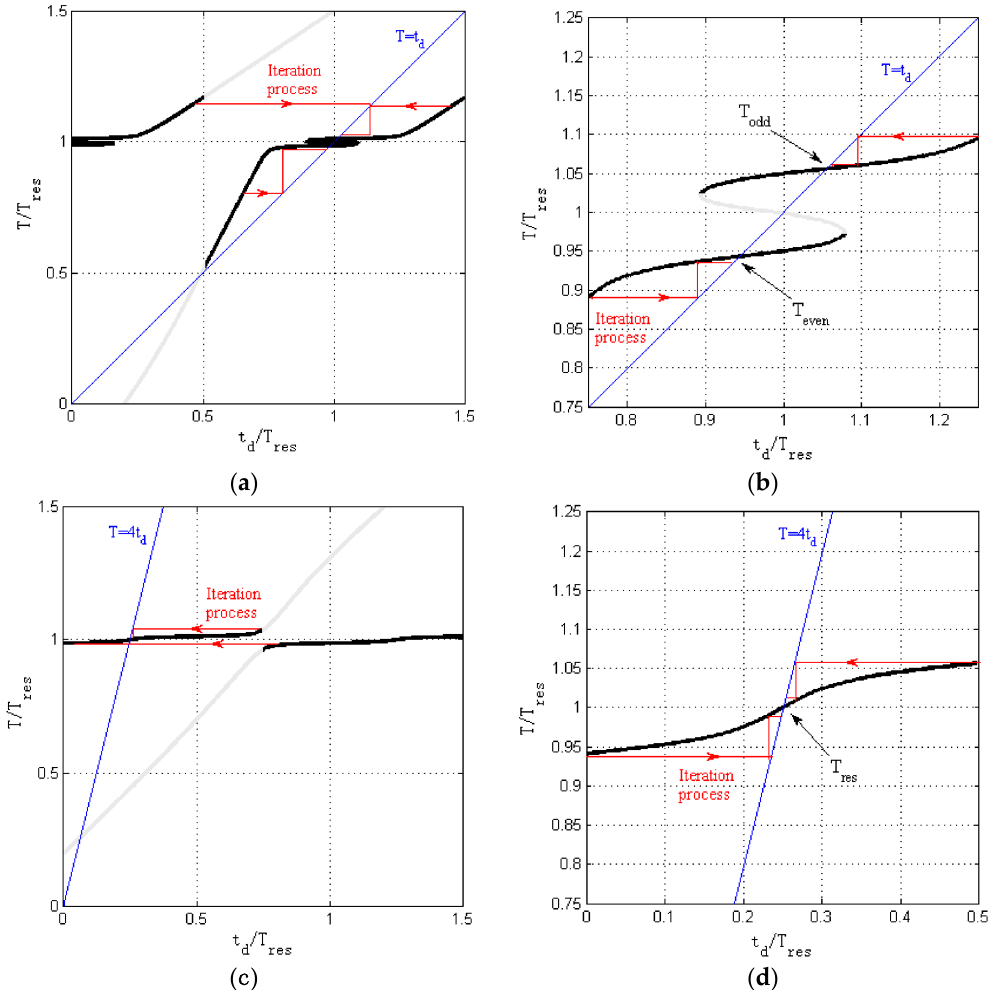
Figure 6. Function F 1,2 ( t d , T ): ( a ) F 1 ( t d , T ) in full range; ( b ) F 1 ( t d , T ) in partial range; ( c ) F 2 ( t d , T ) in full range; and ( d ) F 2 ( t d , T ) in partial range.